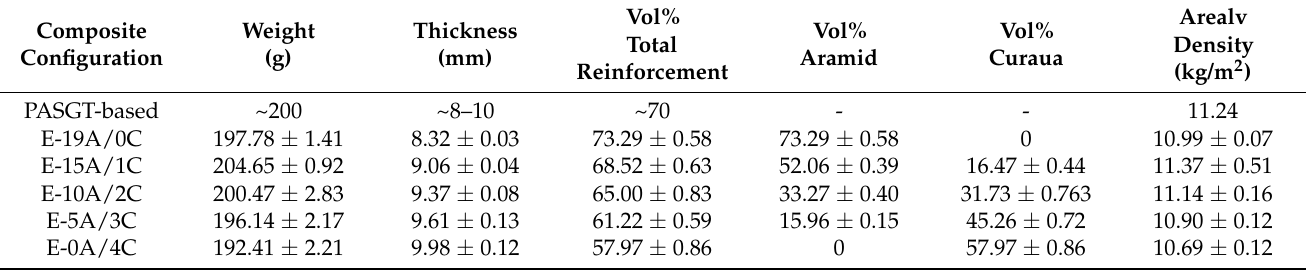
Table 3. Composites’ quantitative characteristics associated with distinct layers